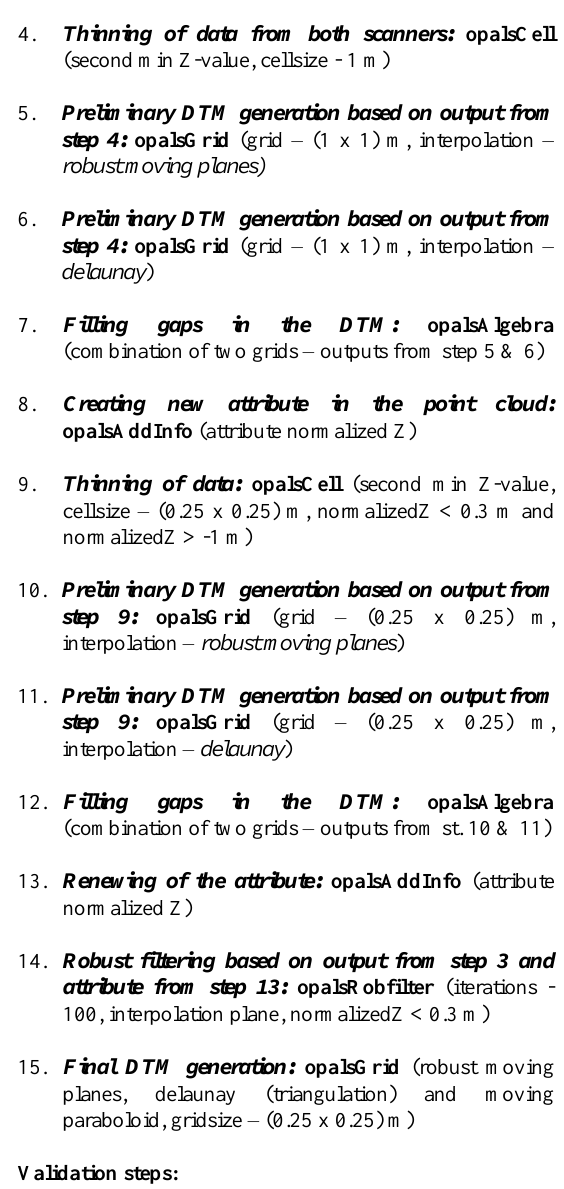
Captured points